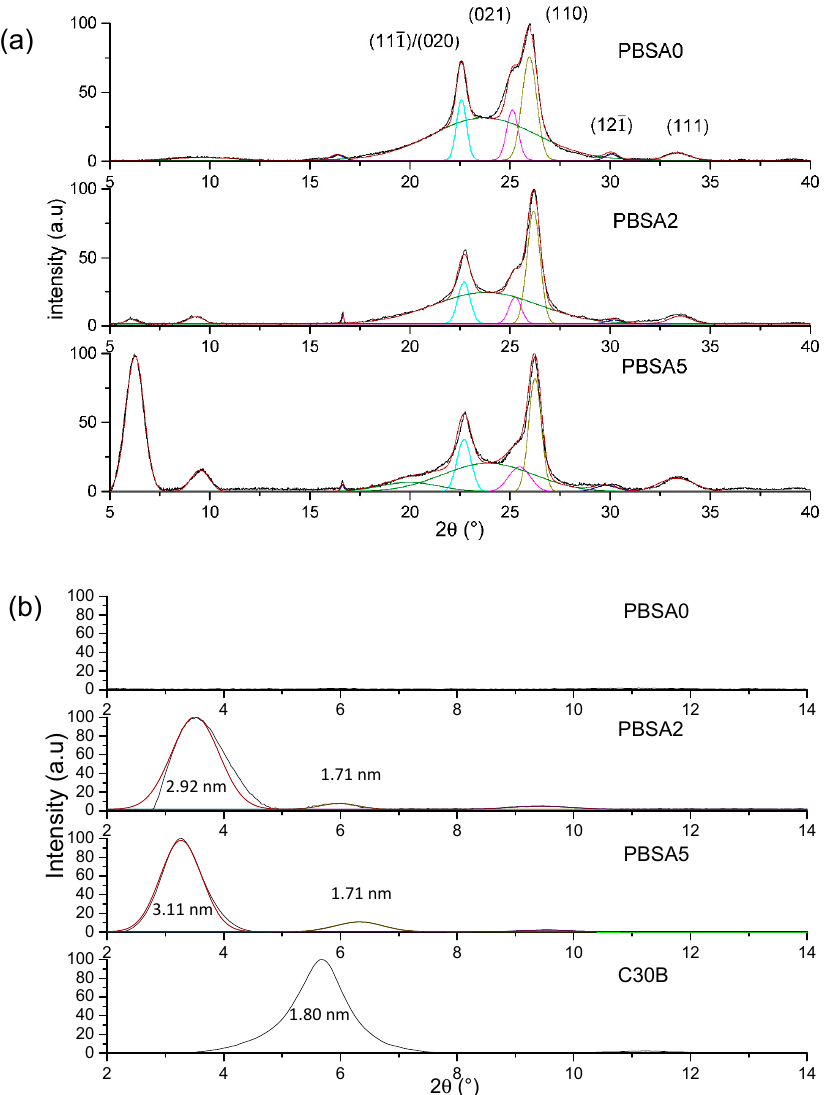
Figure 2. XRD spectra of neat PBSA film and filled PBSA films ( a ) in the 15–40° range and ( b ) in the 2–14° range.